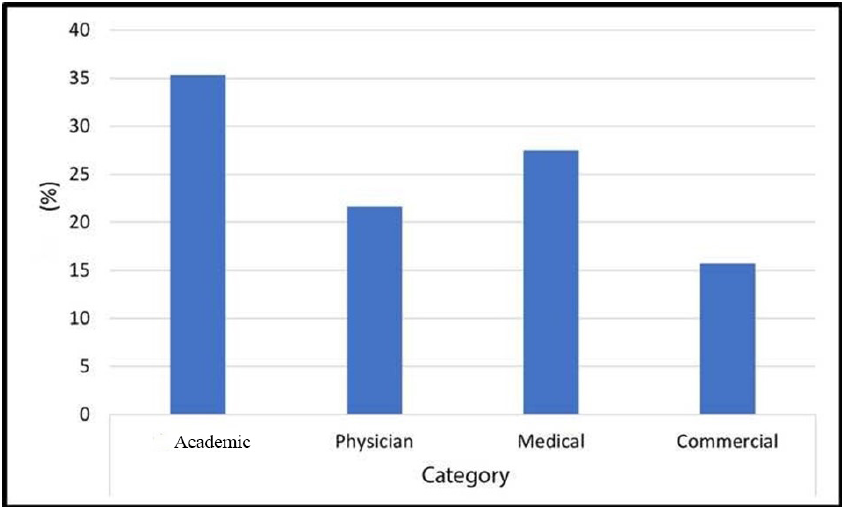
Figure 2. Distribution of websites according to sources. The average DISCERN score was 33.92 ± 13.28, the mean JAMA benchmark score was 2.06 ± 0.89 out of 4 and also the average FKGL and FCRS scores were 8.43 ± 1.98 and 49.85 ± 14.66, respectively (Table 2). Table 2. Minimum, maximum, mean, standard deviation and median values of scores.